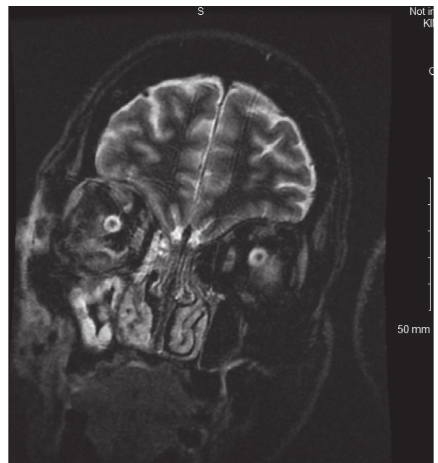
Figure 2: Magnetic resonance